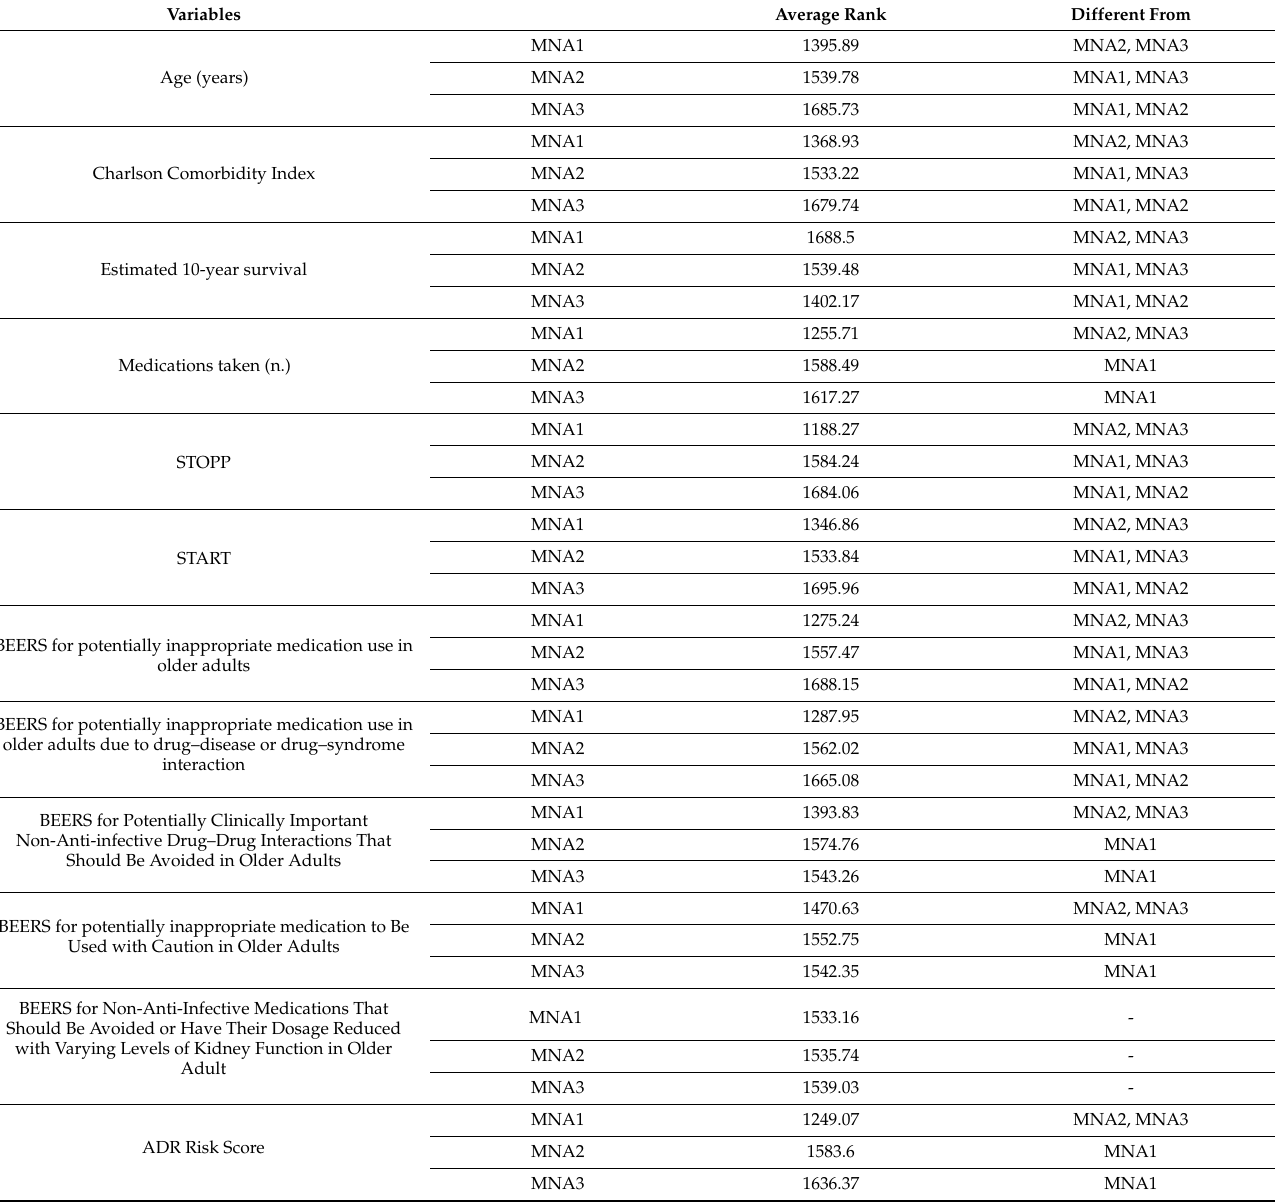
Table 4. Conover Test–MNA: comparison between well-nourished, at risk of malnutrition, and malnourished